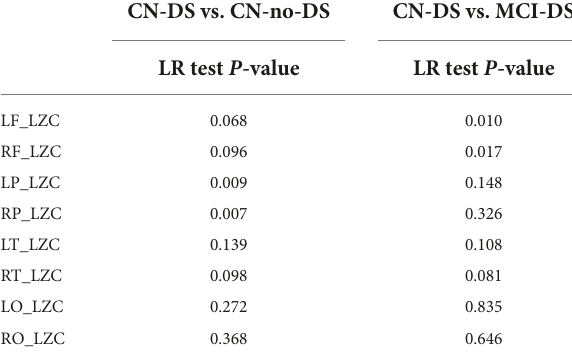
TABLE 4 P -values of the univariate regression models (LR for likelihood-ratio test). CN-DS vs. CN-no-DS CN-DS vs. MCI-DS